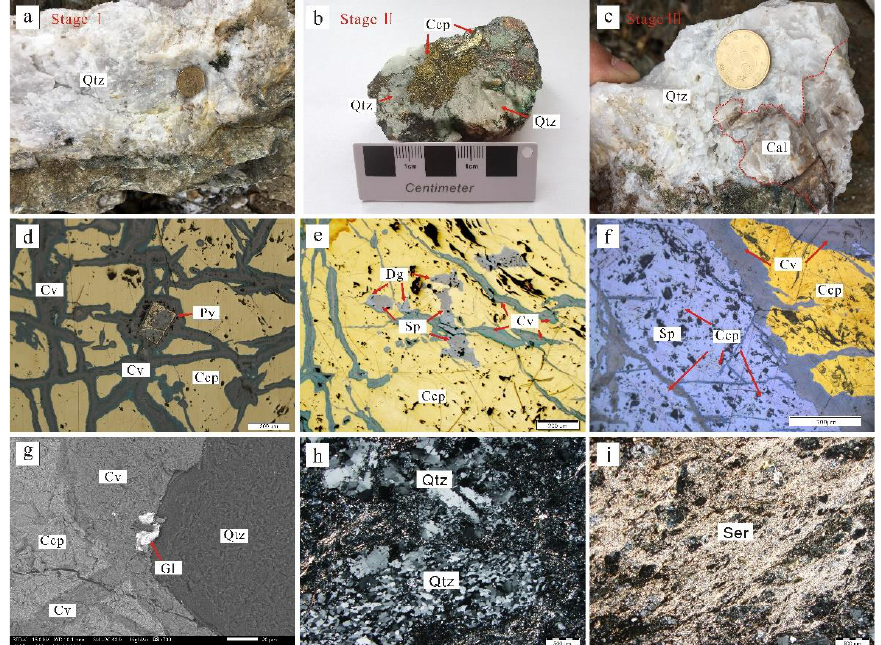
Figure 3. Ore hand specimens, mineralization, and alteration characteristics of the Toudaochuan deposit. ( a ) sulfide-poor quartz vein from stage I; ( b ) gold-bearing polymetallic sulfide–quartz vein from in stage II ( c ) quartz–calcite veins from stage III; ( d ) euhedral–subhedral granular pyrite from stage I was replaced by the stage II sulfides (reflected light); ( e ) the sulfides assemblages in stage II (reflected light); ( f ) minor chalcopyrite distributed in sphalerite with solid-solution separation texture (reflected light); ( g ) native gold in backscatter photographs; ( h ) silicification in the surrounding rock strata near the ore bodies (crossed light); ( i ) sericitization in granite porphyry (crossed light). Abbreviations: Cal = calcite; Ccp = chalcopyrite; Cv = covellite; Dg = digenite; Gl = native gold; Py = pyrite; Qtz = quartz; Ser = sericite; Sp = sphalerite.